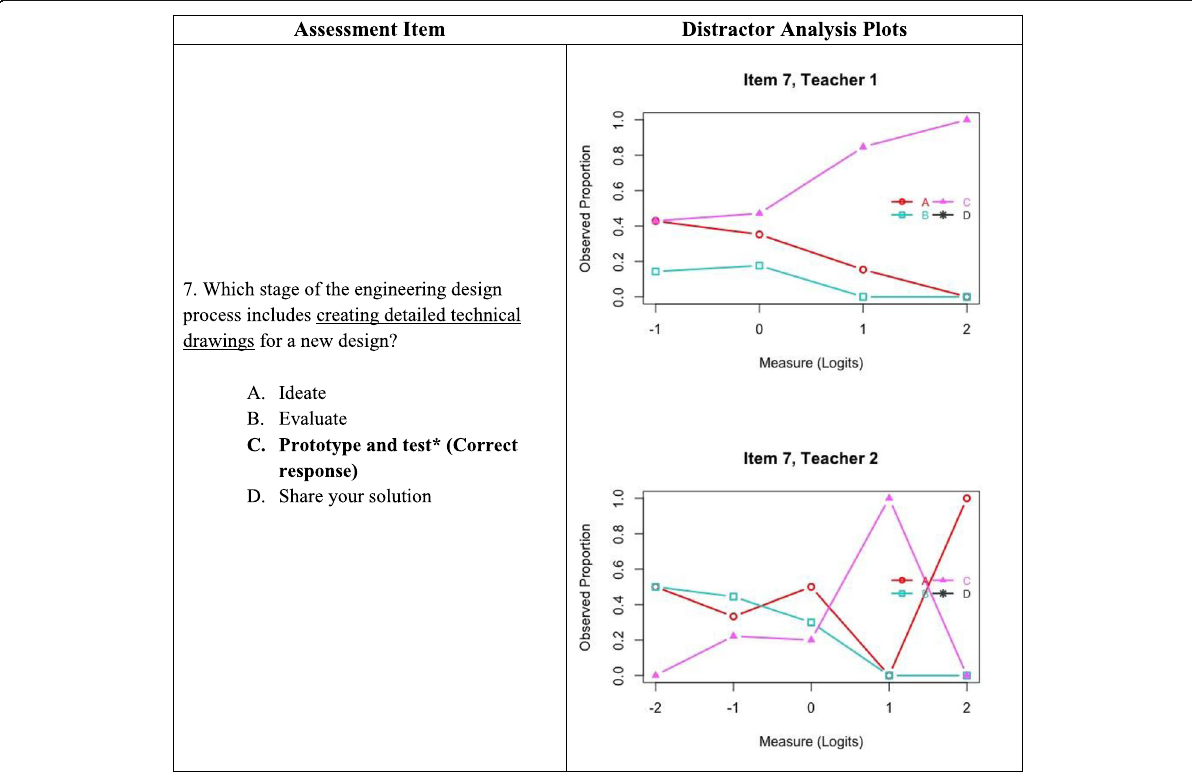
Fig. 7 Distractor analysis plot for item 7: teacher 1 and teacher 2. The plots in this figure show patterns of student answer choices for item 7 in teacher 1 ’ s classroom (top plot) and in teacher 2 ’ s classroom (bottom plot). In both plots, the x -axis displays estimates of student achievement. Student achievement estimates are shown in logits, and these estimates were calculated using the Rasch model. Low values indicate lower achievement, and high values indicate higher achievement. The y -axes shows the observed proportion of responses for a given answer choice. The lines in each plot show the proportion of students who selected each of the four answer choices (A, B, C, or D) at each level of achievement. For this item, the correct response is C (pink line with triangle plotting